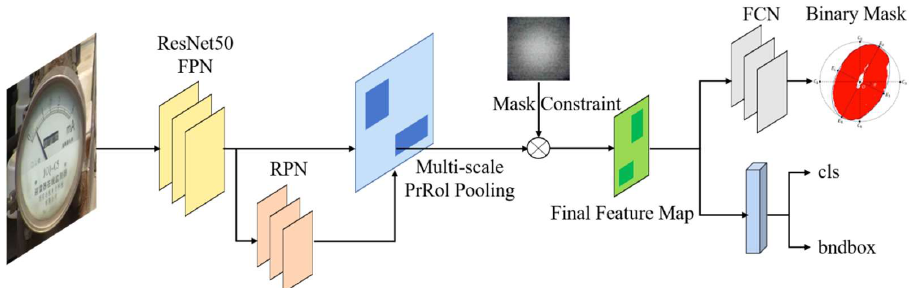
Figure 1. Transfer learning principles diagram.